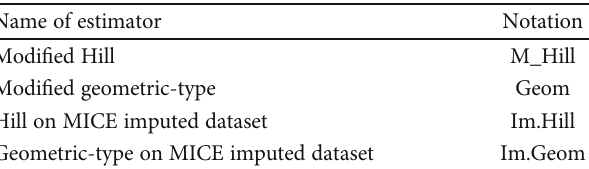
Table 2: Notation of